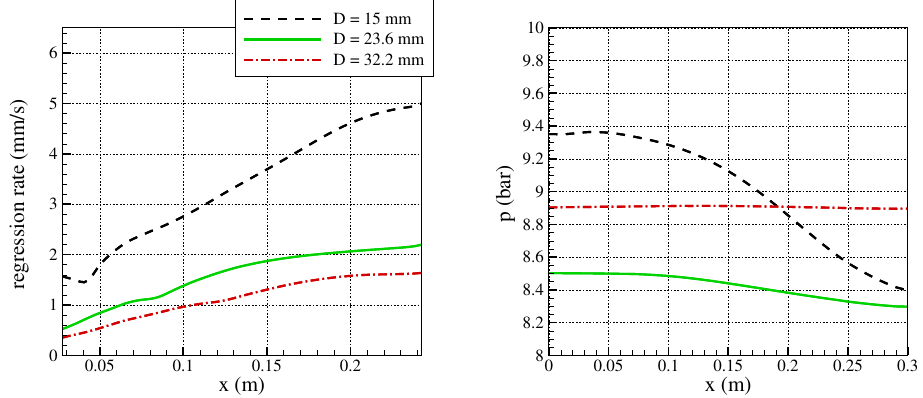
Figure 13. Effect of port diameter on regression rate and pressure for test 3 of set 1.